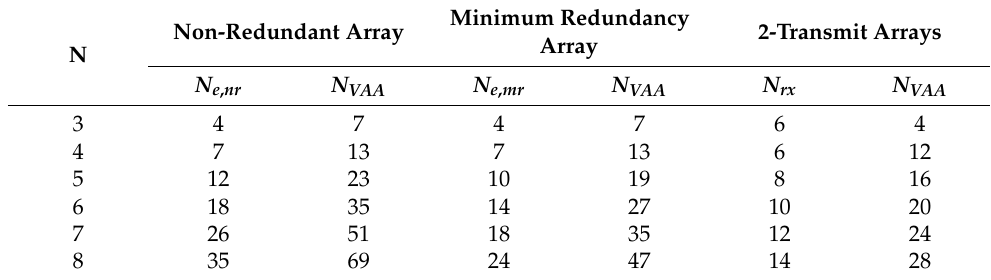
Table 1. List of VAA sizes for the non-uniform array configurations and number.